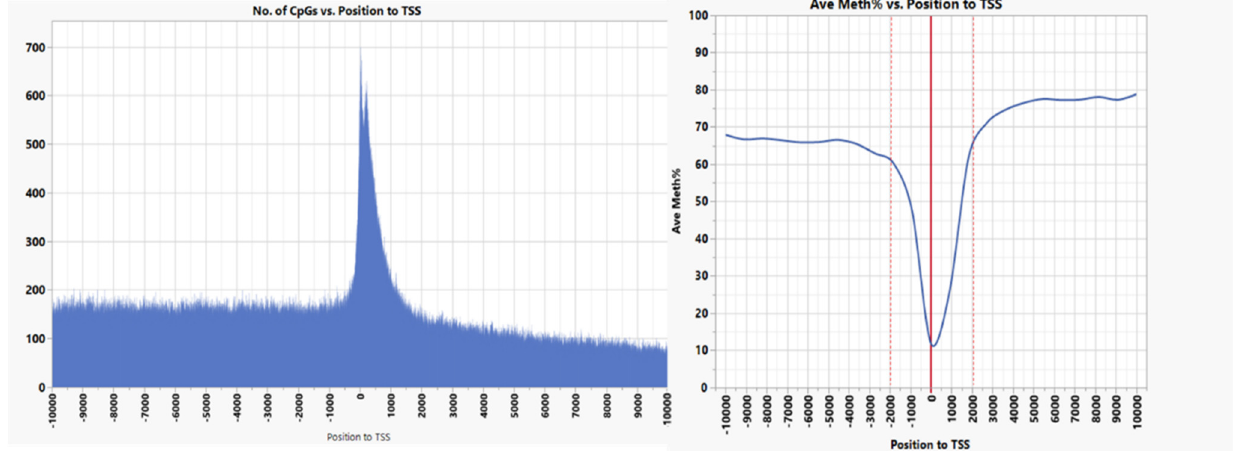
Figure 1. Number of CpGs per nucleotide (left) and their average methylation percentage relative to TSS (right). The average percent of CpGs methylation flanking TSS was 57.7% within ±10 kb and 31.6% within ±2 kb, reaching as low as 12% near the TSS.